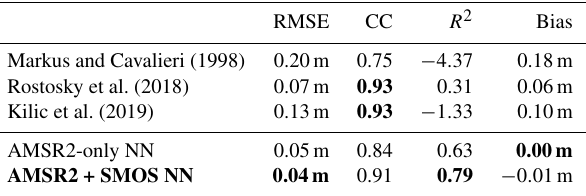
Table 1. RMSE, correlation, coefficient of determination and bias between the different snow depth retrieval algorithms and OIB- measured snow depth for all the test data where SMOS data are available. The best score of each category is highlighted in bold. RMSE CC R 2